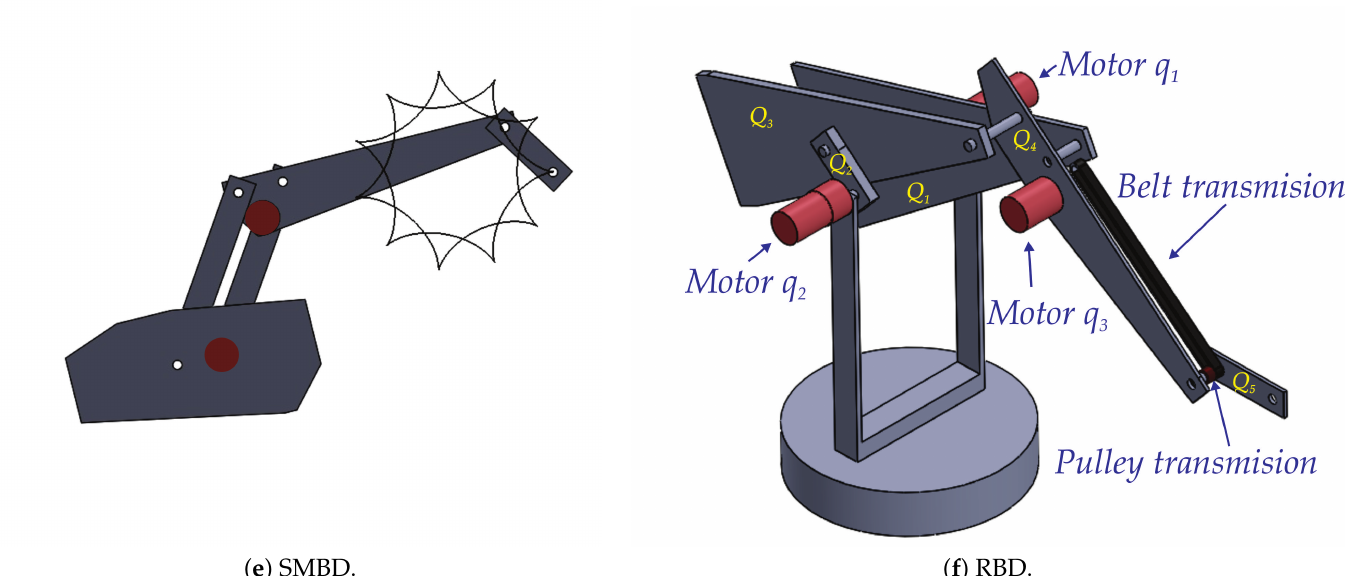
( e ) SMBD. ( f ) RBD. Figure 8. CAD of the different design approaches. Lateral views of the obtained links ( a – e ). Isometric view ( f ) of the RBD with